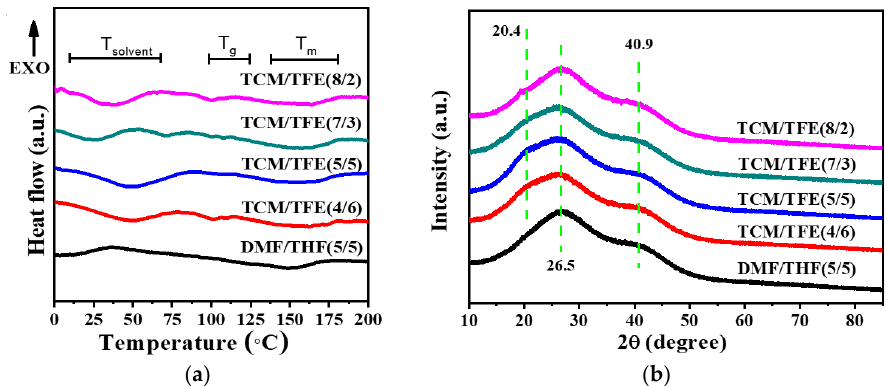
Figure 5. Mechanical properties of TCM/TFE and DMF/THF electrospun nanofibers: ( a ) typical stress- strain curves, ( b ) tensile strength, ( c ) modulus, ( d ) strain at break.